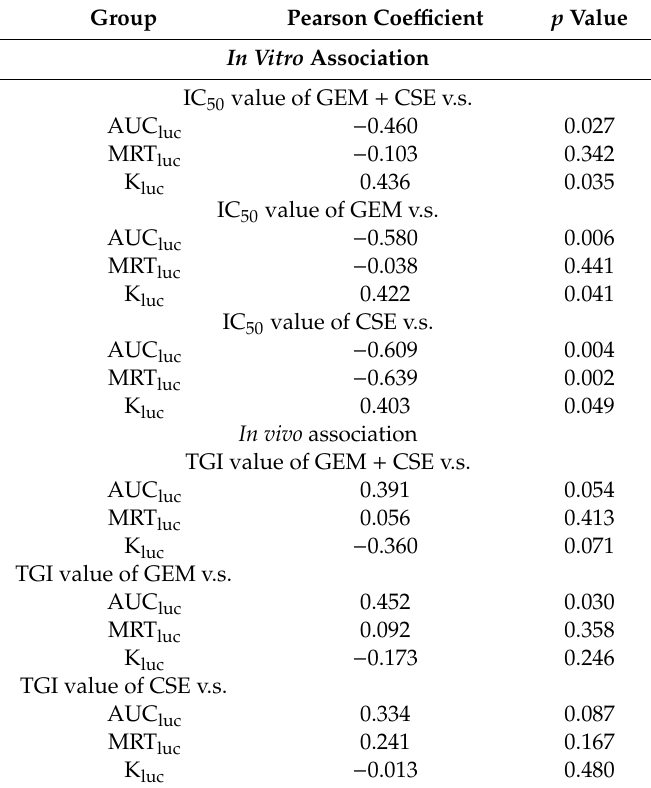
Table 4. The association between IC 50 value / TGI value and the pharmacokinetic parameters by di ff erent treatment